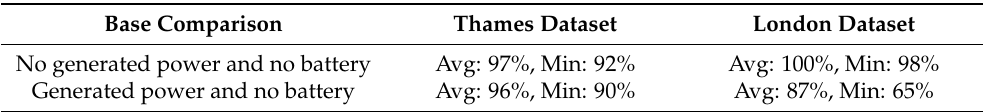
Table 3. Relative performance of the smart algorithm with constant generation and demand uncer- tainty compared to perfect forecasts in the simulated Thames or London environment. The underlying basis for comparison is no battery and/or generated power (Table